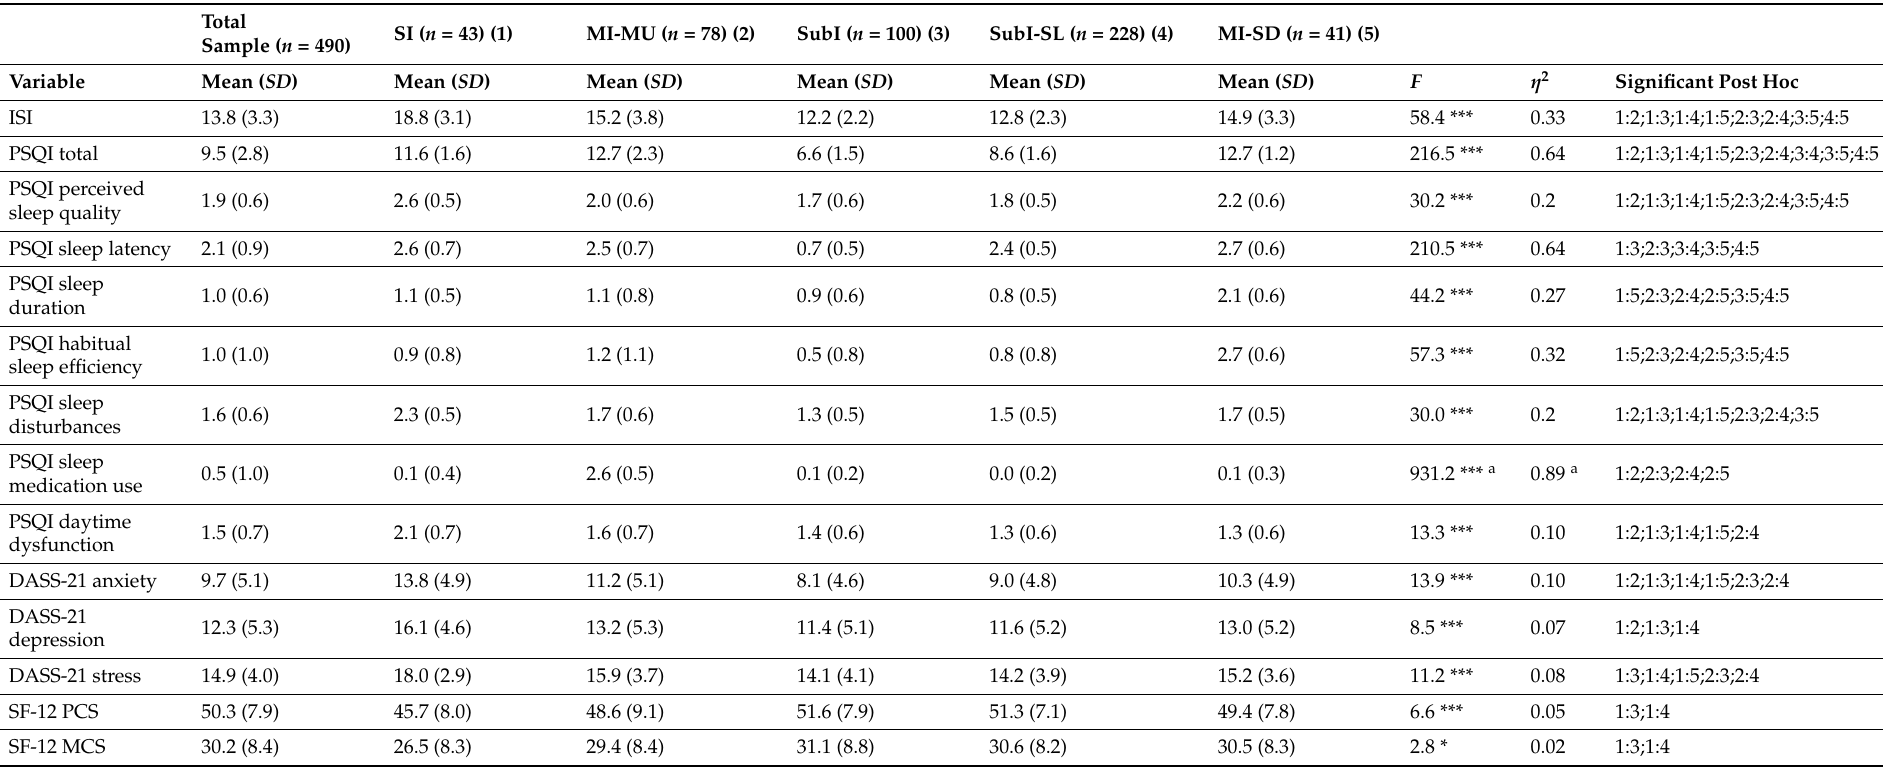
Table 2. Participants’ mean ISI, PSQI, DASS-21, and SF-12 scores and mean differences between identified insomnia